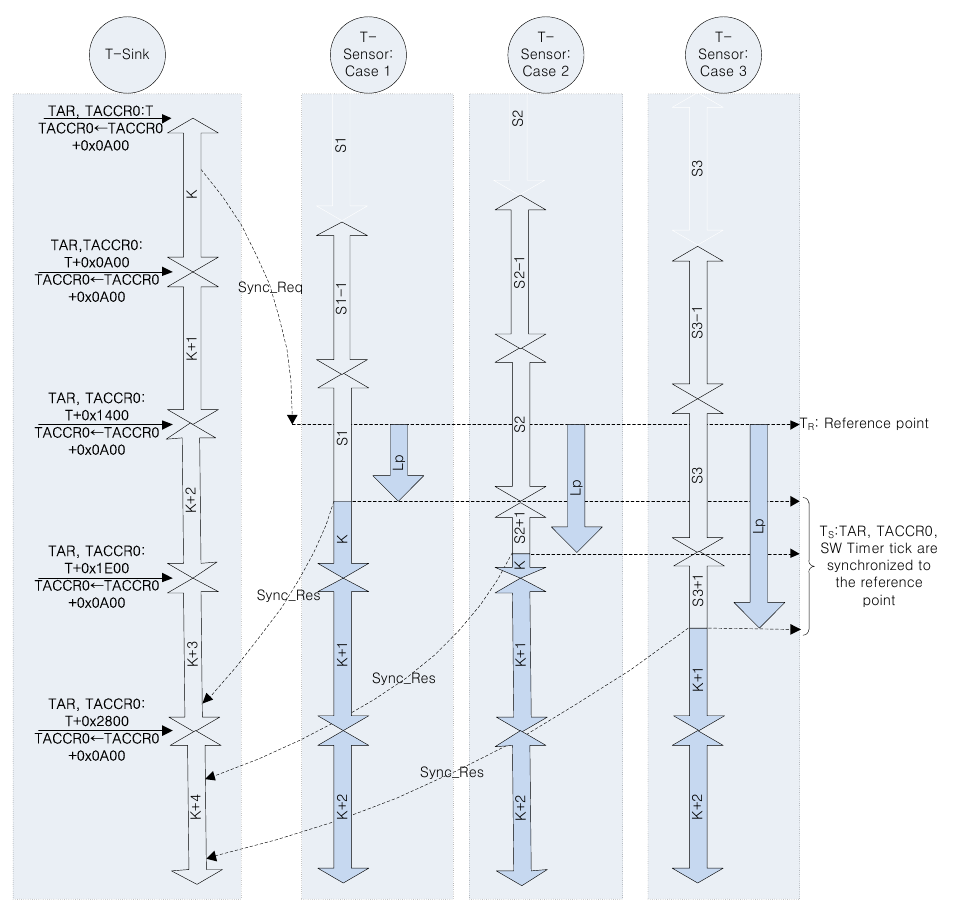
Figure 4. Timing diagram of the synchronization procedure of T-Sensor nodes to the T-sink node.